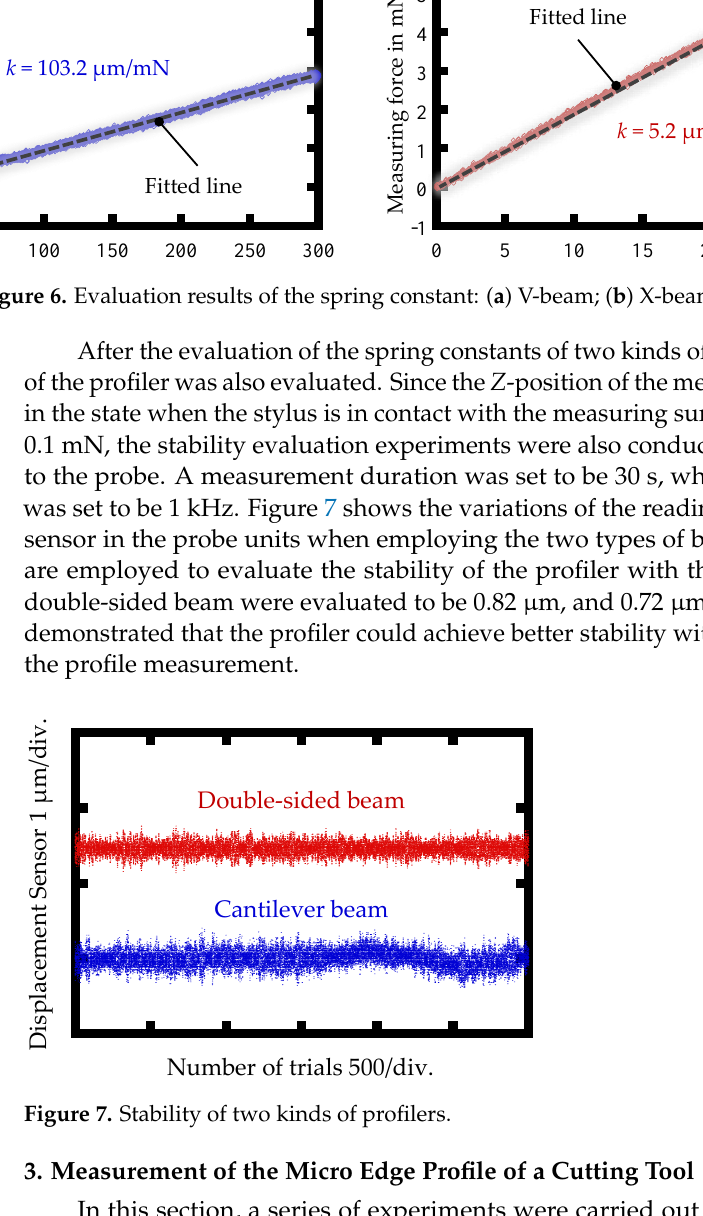
Figure 6. Evaluation results of the spring constant: ( a ) V-beam; ( b ) X-beam.